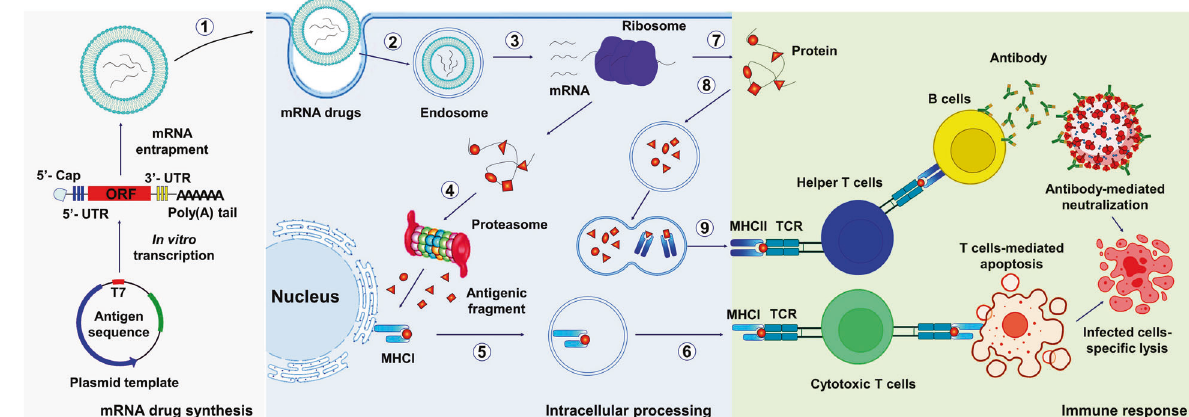
Fig. 8 mRNA drugs elicit immunity using disease-speci fi c targeting antigen strategies. mRNA drugs mainly go through the following three aspects from synthesis to initiate immune protection, including mRNA synthesis, intracellular processing, and initiating immune protection. Brie fl y, IVT mRNA drugs are encapsulated into carriers (such as nanoparticles) and are endocytosed by antigen-presenting cells ( ① - ② ); mRNA is released into the cytoplasm after escaping from endosomes and then translated into antigenic proteins by ribosomes ( ③ ). Subsequently, endogenous antigens are degraded into polypeptides by the proteasome and are presented by MHC I and activate cytotoxic T cells (CD8 + T cells) ( ④ - ⑥ ). In addition, secreted antigens can be taken up by cells, degraded inside endosomes, and presented on the cell surface to helper T cells by MHC class II proteins ( ⑦ - ⑨ ). Finally, helper T cells (CD4 + T cells) stimulate B cells to produce neutralizing antibodies against pathogens